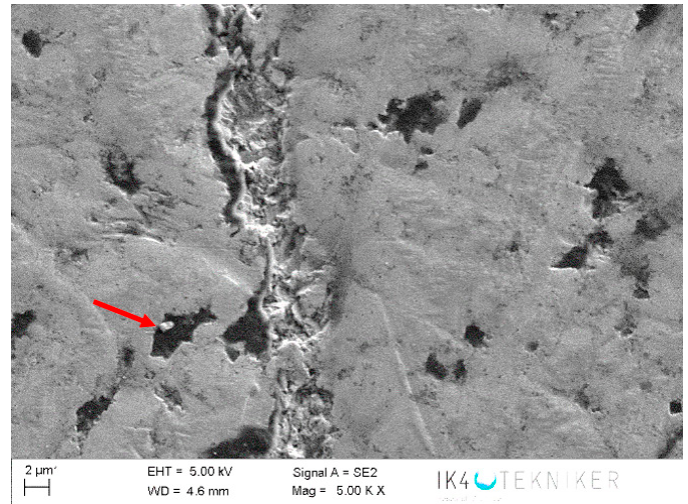
Figure 19. SEM image of a tested area of the disc against a PA46Z pin.